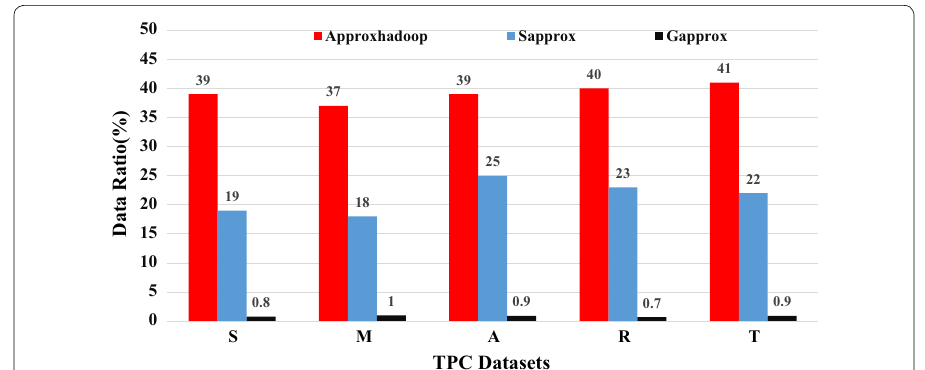
Fig. 8 Amount of data must be processed to achieve the sampling requirements (TPC datasets)